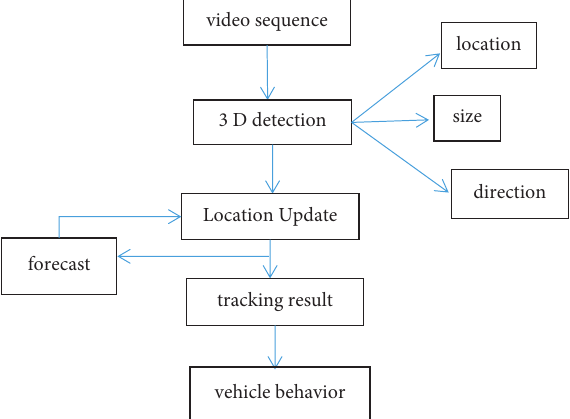
Figure 1: Schematic diagram of algorithm